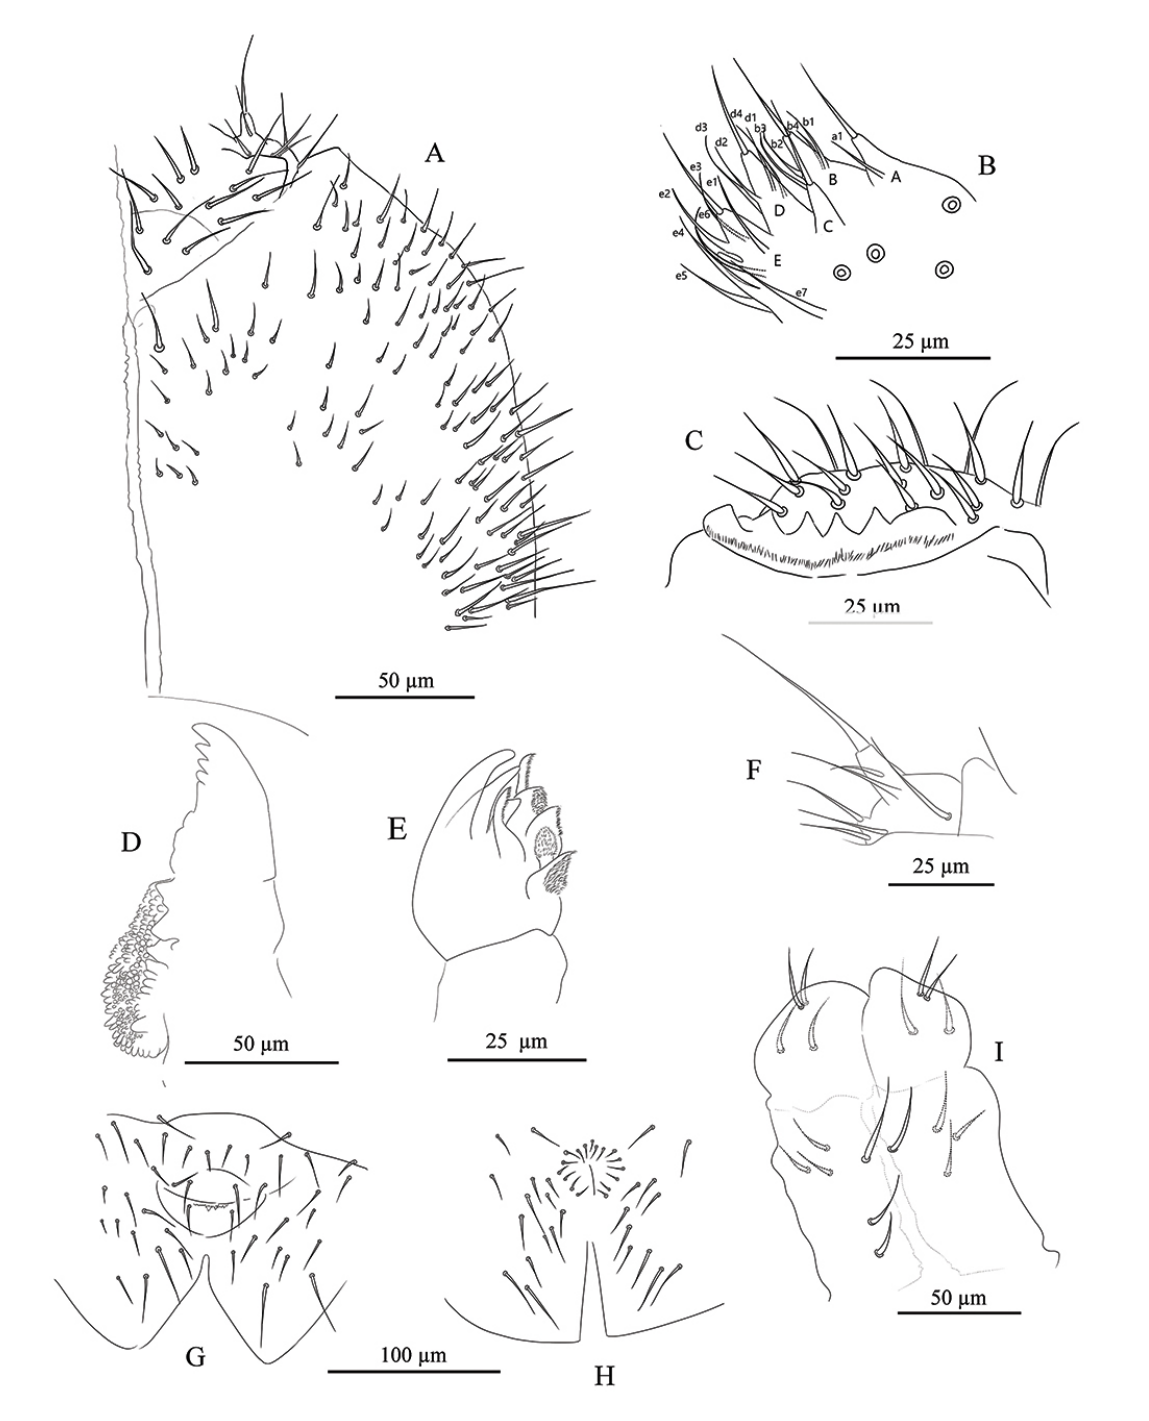
Fig. 4 . Desoria calderonis sp. nov . A . Ventral chaetotaxy of head. B . Labial palps. C . Labrum. D . Mandible. E . Maxilla. F . Maxillary palp. G . Female genital opening. H . Male genital opening. I . VT in posterior